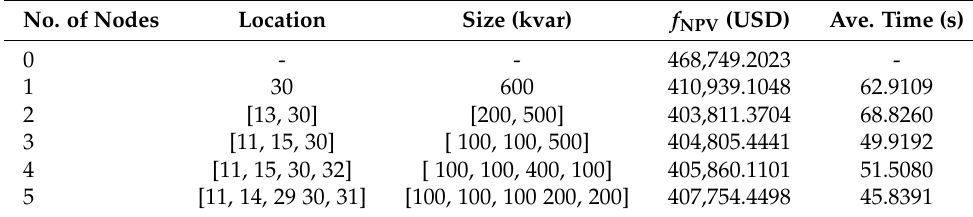
Table 3. Numerical results for the IEEE 33-bus grid with a radial topology.